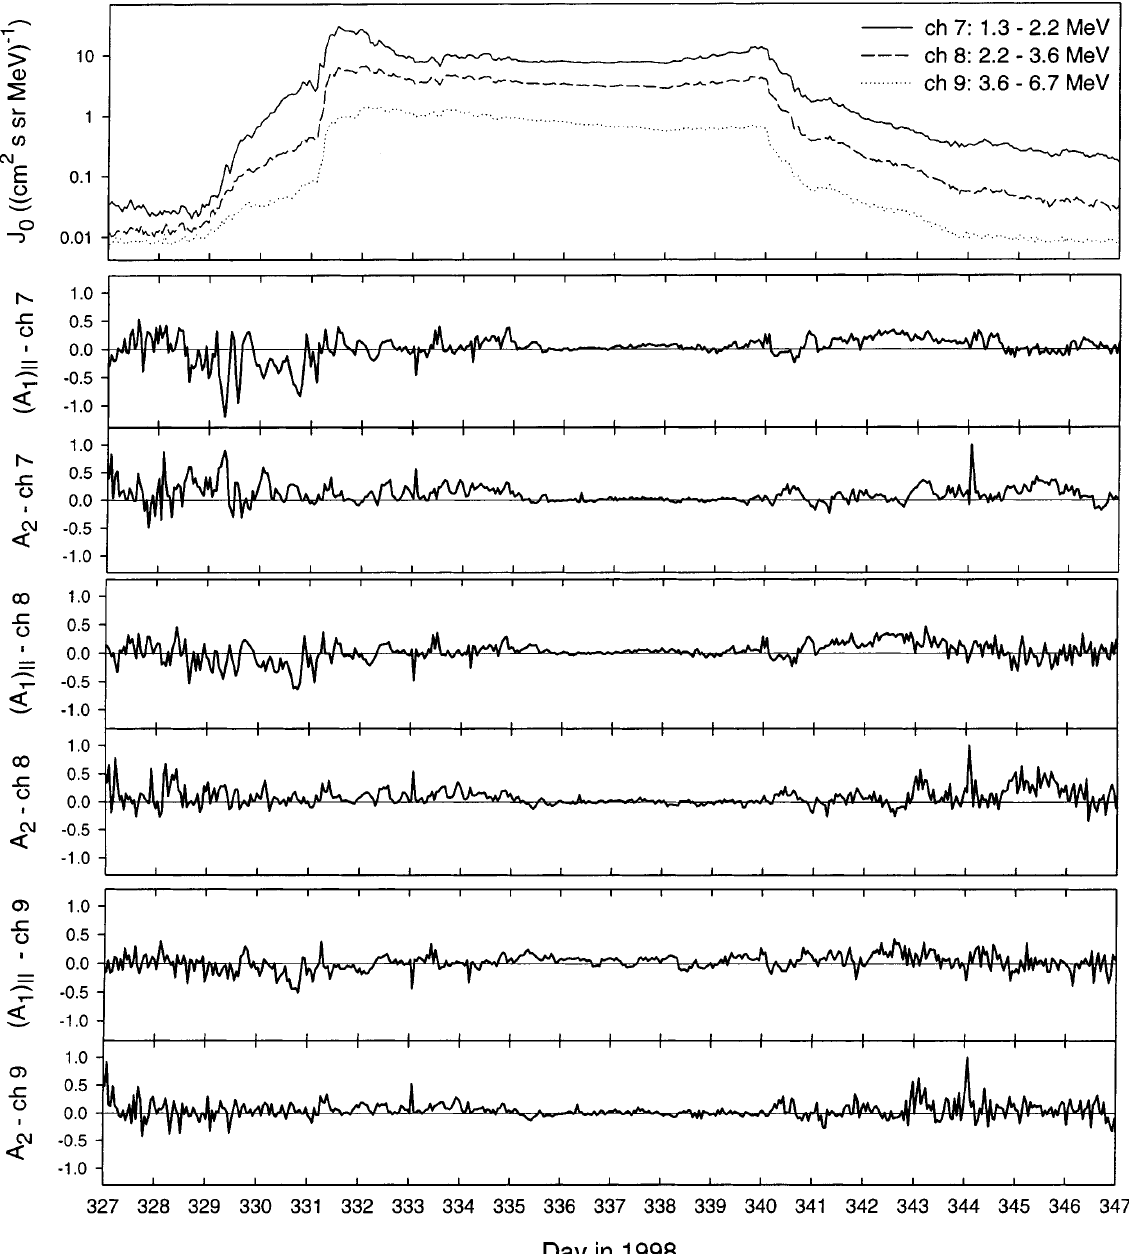
Fig. 3. ATs anisotropy results for three sectored energy